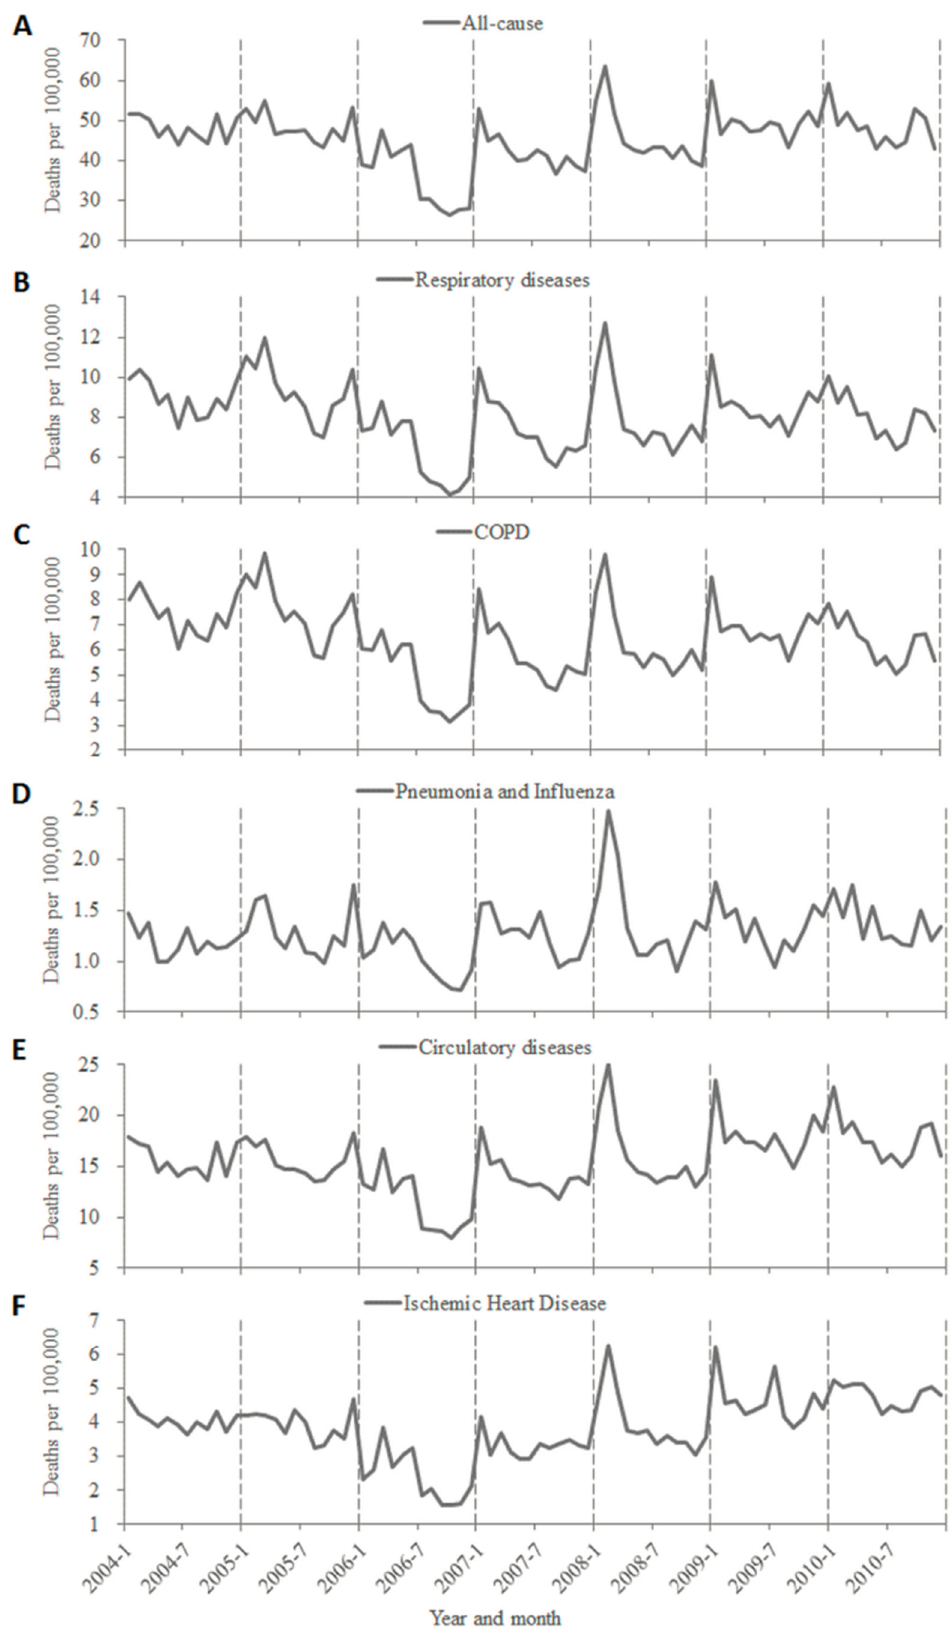
Figure 4. Monthly deaths per 100,000 people by underlying causes in Southern China, 2004–2010. ( A ) All-cause; ( B ) Respiratory diseases; ( C ) COPD; ( D ) Pneumonia and influenza; ( E ) Circulatory diseases; ( F ) Ischemic heart